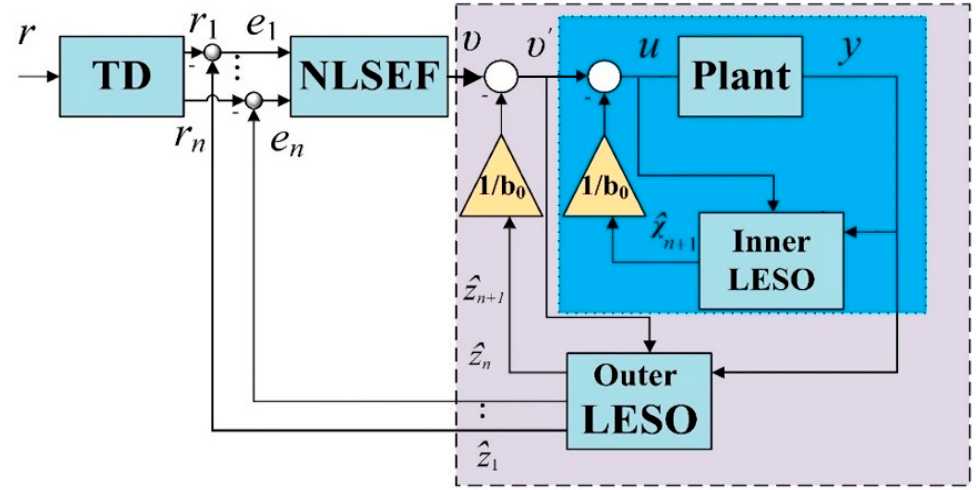
Figure 2. The Novel Active Disturbance Rejection Control (N-ADRC) structure with nested Linear Extended State Observers (LESOs).